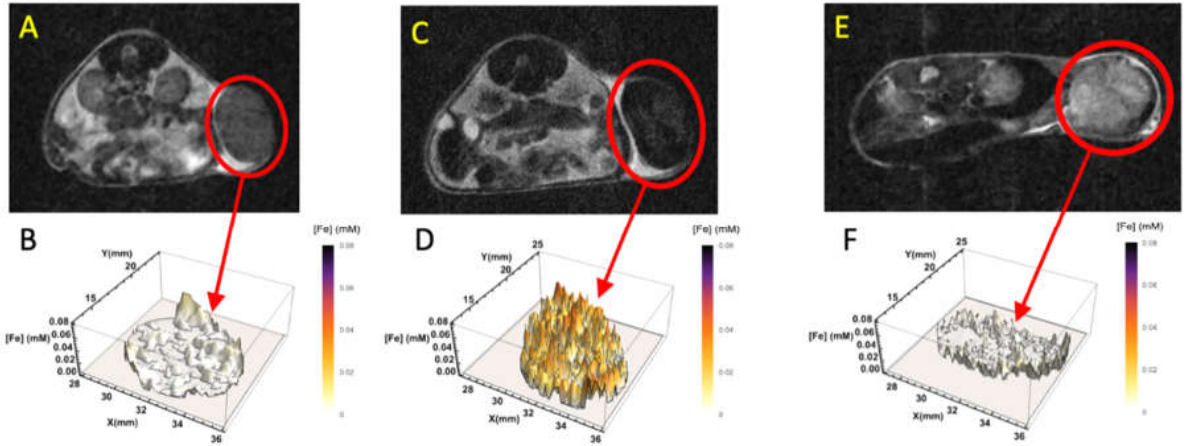
Figure 7. Representative, T2w MR images ( A , C , E ), and quantitative 3D [Fe]MRI plots ( B , D , F ), of the time-dependent, spatial Fe distribution c(x,y,z,t) showing the uptake and metabolism of added SPION-iron within the tumors. ( A ) T2w MR image and ( B ) a quantitative 3D [Fe]MRI plot of the tumor in ( A ; red circle) taken prior to SPION injection. ( C ) T2w MR image and ( D ) a quantitative 3D [Fe]MRI plot of the tumor in ( C ; red circle) taken 24 h after SPION injection. ( E ) T2w MR image and ( F ) a quantitative 3D [Fe]MRI plot of the tumor in ( C ; red circle) taken 7 days after SPION injection. Note the large increase in the Fe signal within the tumor ( D ; [Fe] ~0.05 mM) reflecting the Fe uptake by the tumor-associated macrophages. Iron images taken 7 days after SPION injection ( F ) showed the return to pre-SPION-injection levels of iron.